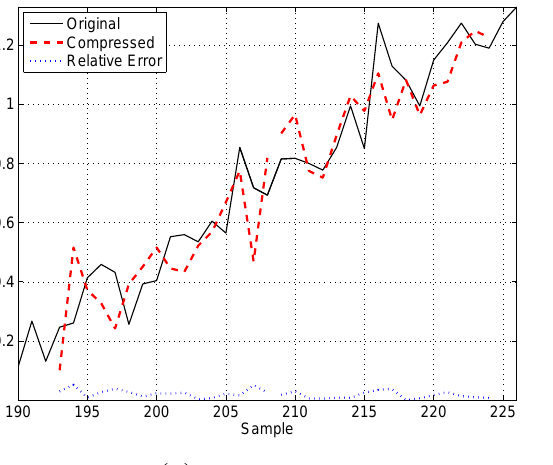
Figure 3. A qualitative example of the transmission procedure for N = 16 , K = 8 and b = 8 : ( a ) shows two consecutive segments (thin black solid line) of N samples, as well as the related compressed values (bold red dashed lines) and the relative compression error (thin blue dotted lines in the bottom part of the chart); ( b ) shows the result of the decompression operation comparing a longer segment of the original signal (thin black solid line) with the received data after the decompression (bold blue dashed